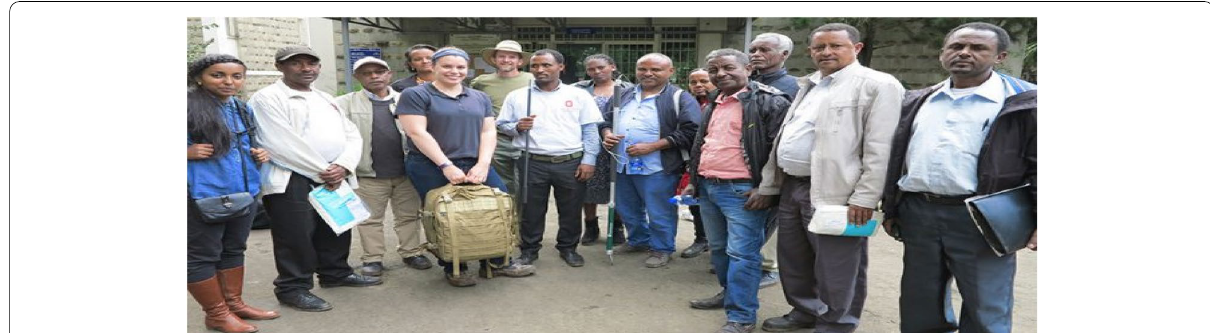
Fig. 6 CDC and Ethiopian animal rabies surveillance officers in Ethiopia, 2016